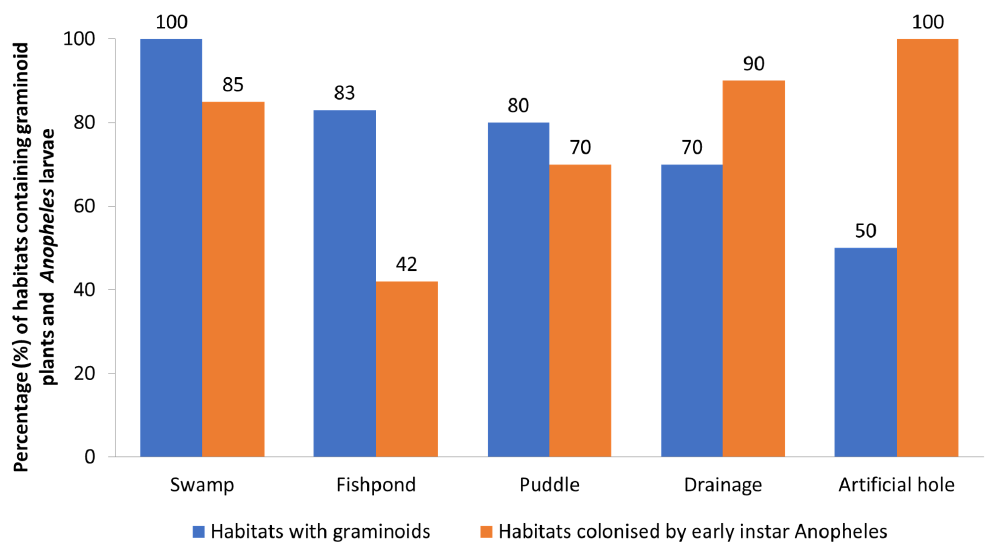
Figure 3. Bar graph showing percentage of habitats containing graminoid plants and being colonised by early instar Anopheles